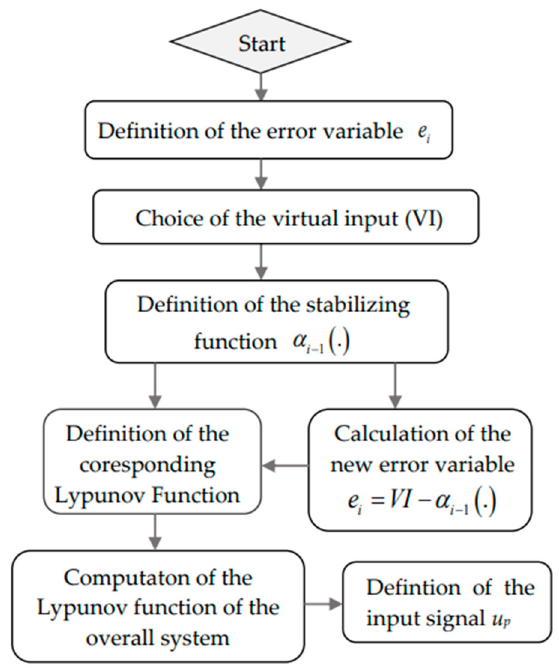
Figure 4. Basic principles of the controller position.